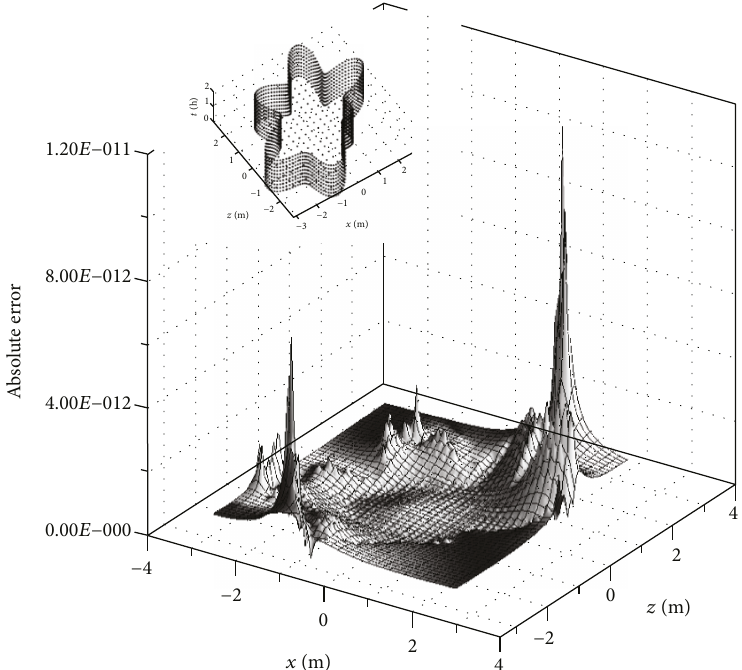
Figure 11: The absolute error of the computed results for the modeling of two-dimensional transient fl ow in unsaturated soils.